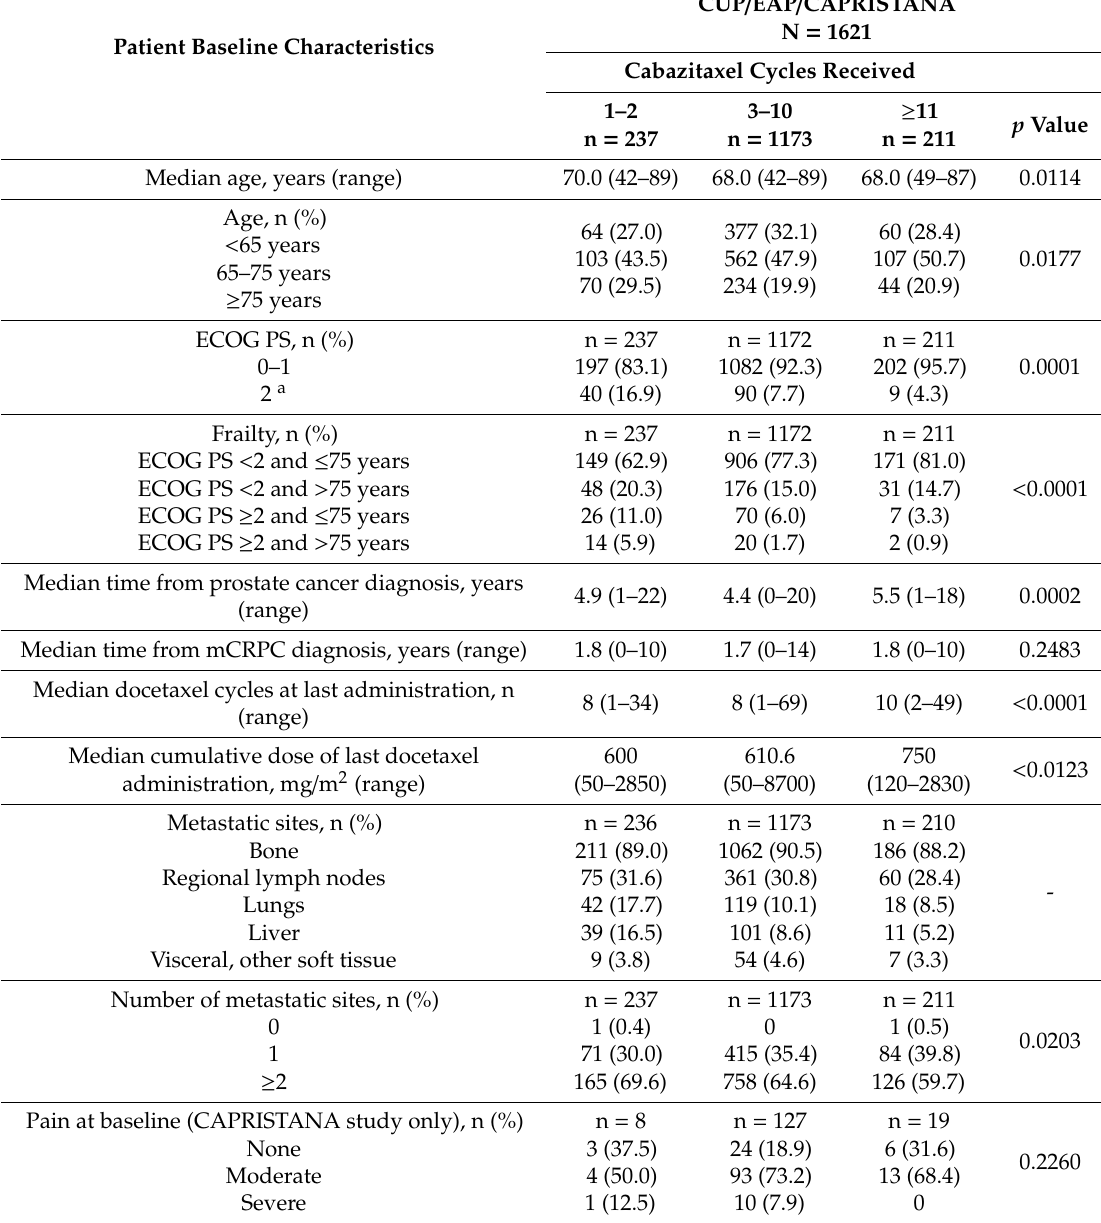
Table 4. Patient baseline characteristics according to the number of cabazitaxel treatment cycles received (1–2 vs. 3–10 vs. ≥ 11 cycles) across the CUP / EAP and CAPRISTANA